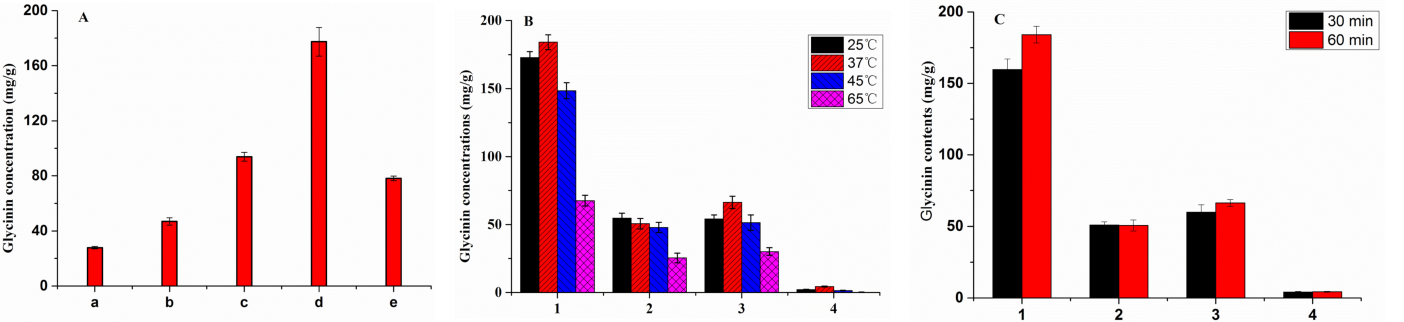
Figure 3. ( A ) Optimization of methods for extraction buffer solutions on glycinin extraction efficiency of soybean meals ( n = 3). (a) 0.01 M PBS (pH 8.0); (b) 50 mM Tris-HCl (pH 9.0); (c) 50 mM Tris-HCl (pH 10.0); (d) 50 mM Tris-HCl buffer (pH 10.0, 0.9% β -mercaptoethanol); (e) Aqueous solution of sodium hydroxide (pH 10.0). ( B ) Optimization of methods for 1 h extraction temperature of glycinin ( n = 3). (1) Soybean meals; (2) extruded full-fat soybean; (3) Fermented soybean meal; (4) proteolytic soybean meal. ( C ) Optimization of the extraction time on glycinin extraction efficiency of soybean products ( n = 3). (1) Soybean meals; (2) extruded full-fat soybean; (3) fermented soybean meal; (4) proteolytic soybean